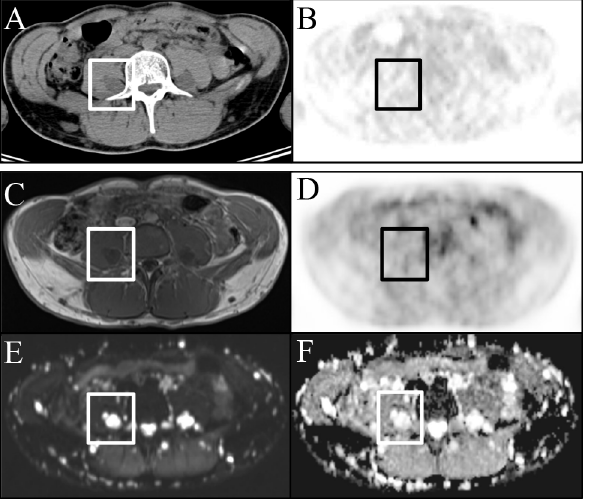
Fig 4. PNST in a 22 -year male patient. (A) CE-CT image and corresponding(B) PET image with no pathological glucoseuptake. (C) T1w image and corresponding (D) PET images with also no abnormalfocal tracer uptake. (E) DWI (b800) and (F) ADC maps showingrestricted diffusionbut high signal on the ADC map.